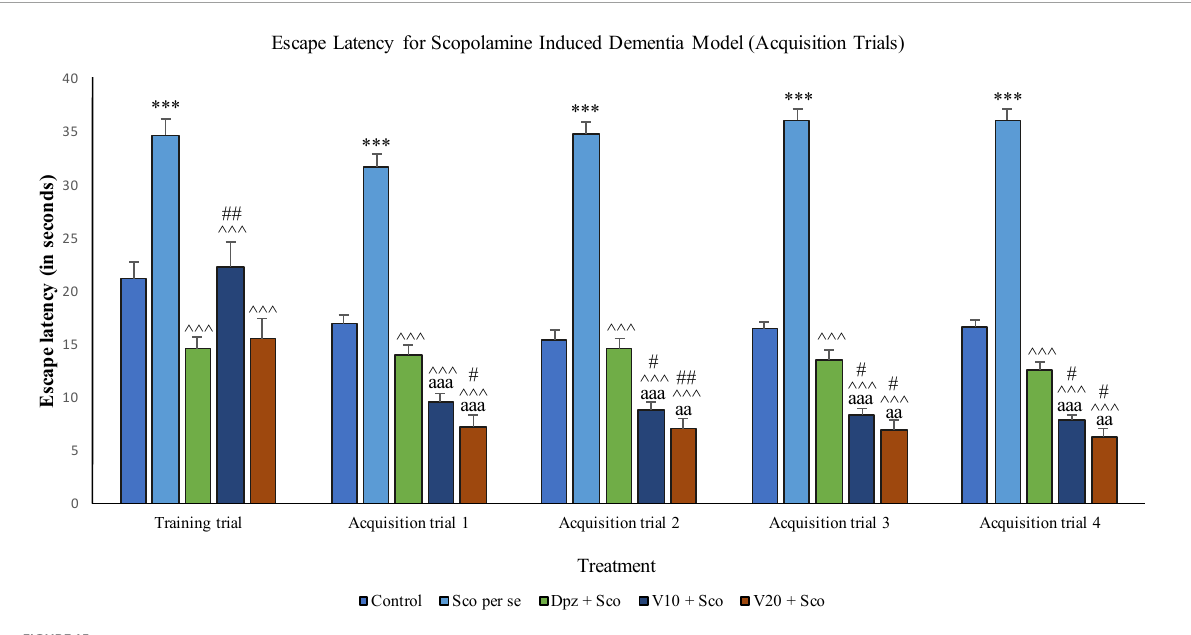
FIGURE15 Effect of vanillin and other treatments on escape latency (acquisition trials). Data are expressed as mean ± SEM. “***” denotes P < 0.001 with respect to the control group within the same day. “##” denotes P < 0.01 with respect to the standard treatment group within the same day, and “#” denotes P < 0.05 with respect to the standard treatment group within the same day. “ ∧∧∧ ” denotes P < 0.001 with respect to the negative control group (Sco per se ). “aaa” denotes P < 0.001 with respect to the acquisition time of the same group during the training trial, and “aa” denotes P < 0.01 with respect to the acquisition time of the same group during the training